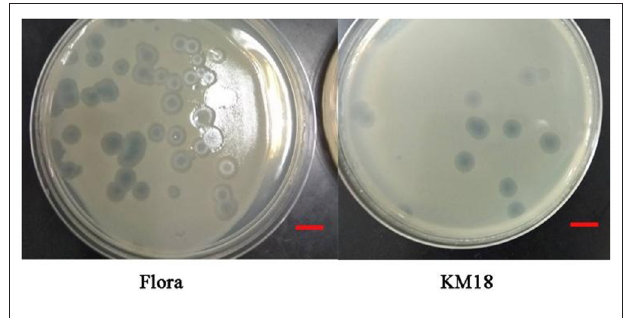
FIGURE 1 | Plaques formed by E. coli phages KM18 and Flora; the host strain was E. coli BL21 incubated overnight at 37 ◦ C. The scale was 1cm.